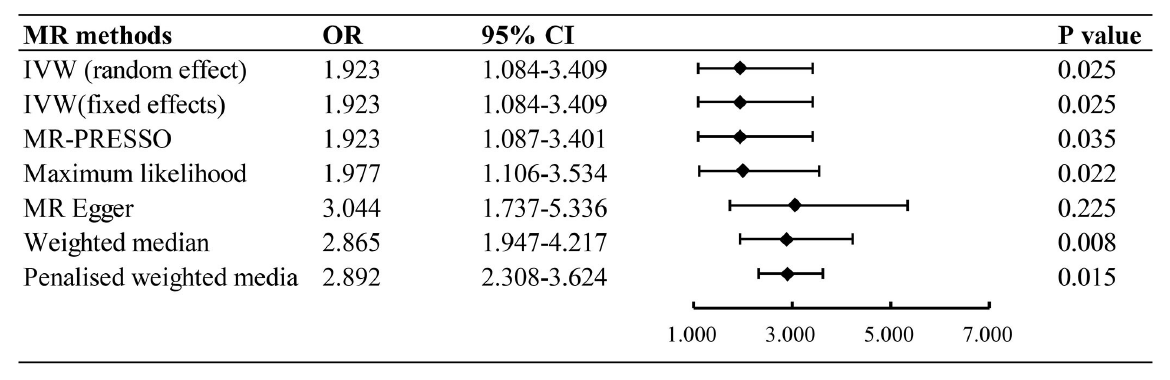
FIGURE2 Associations of genetically predicted processed meat intake with risk of lung cancer. OR, odds ratio; CI, confidence